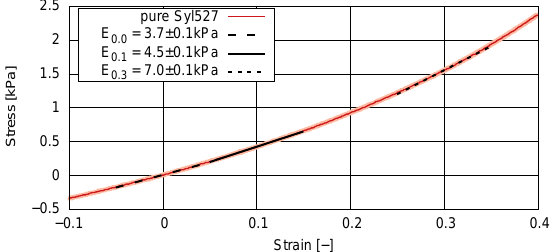
Figure 8. Deformation behaviour of pure Sylgard